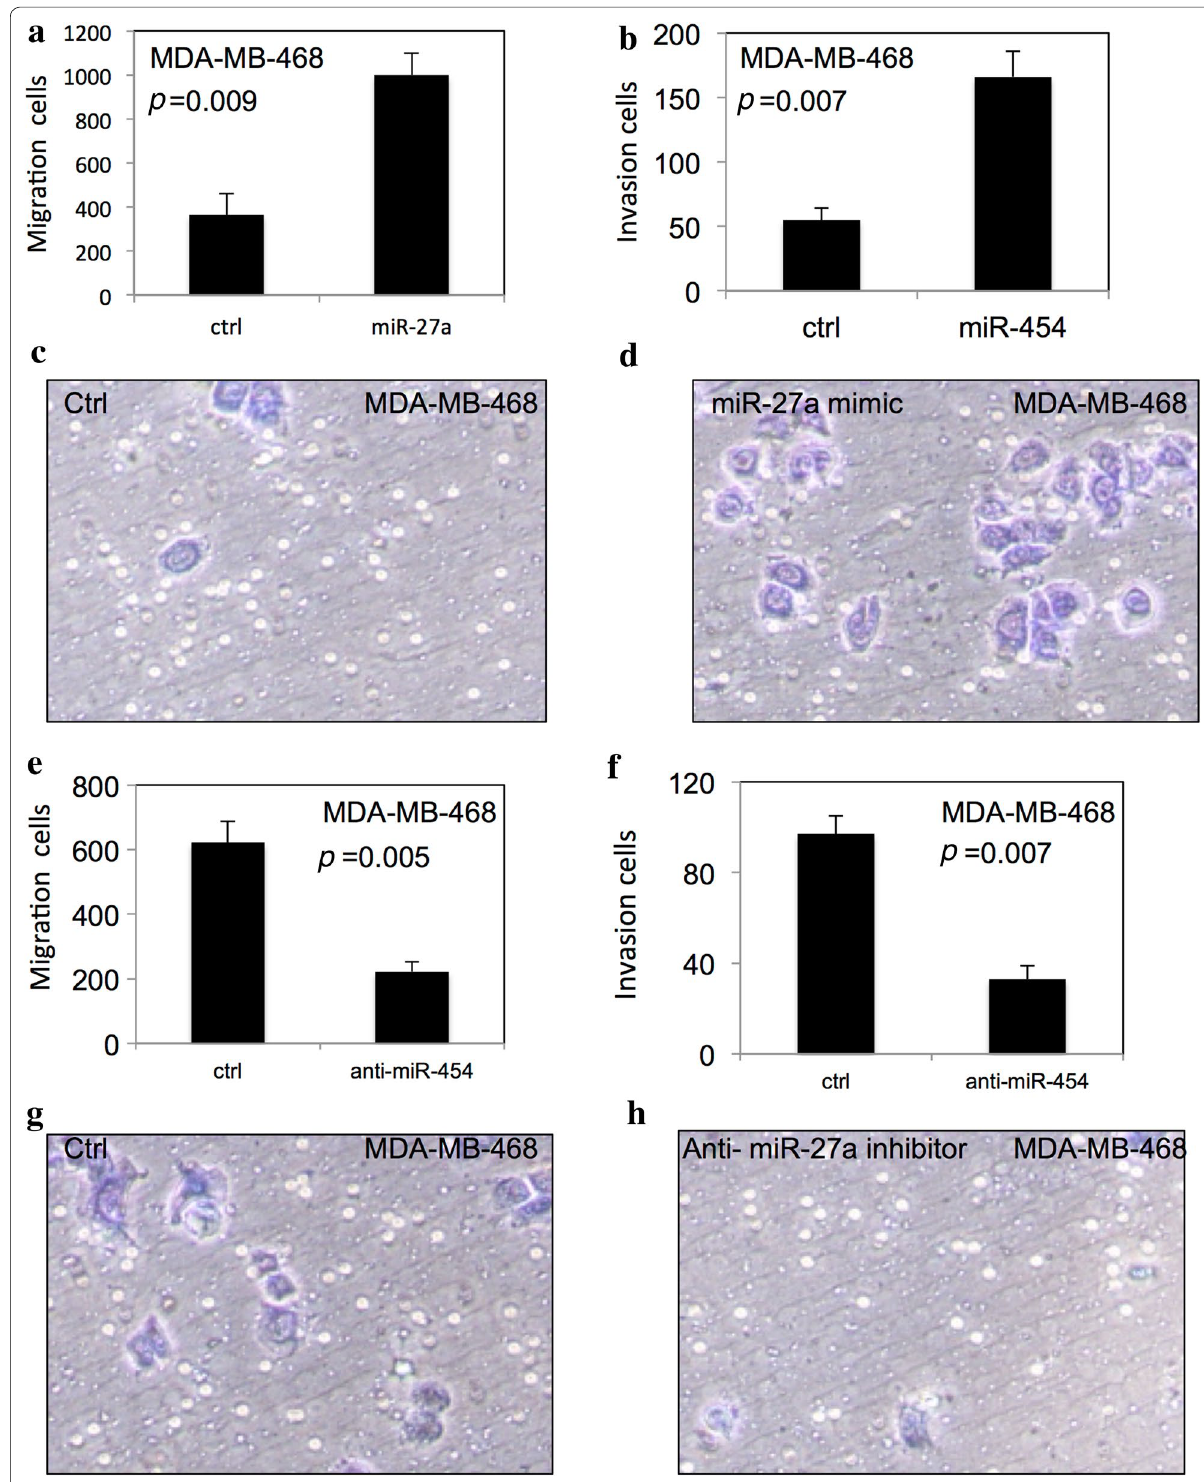
Fig. 5 miR-454 improved migration and invasion of TNBC cells. miR-454 improved migration and invasion in MDA-MB-468 cells ( a – h ). All experi- ments were performed in